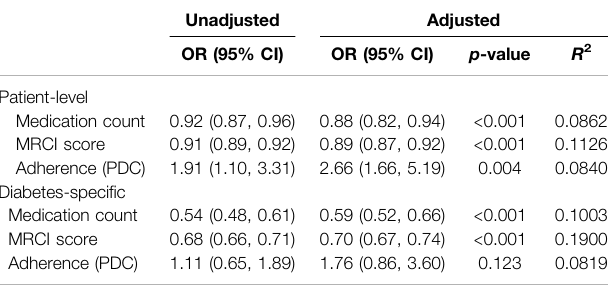
TABLE 3 | Association between medication parameters and HbA1c level ( ≤ 7.0%) of study cohort from “ EnPHC-Eva: Facility ” Malaysia, 2018-2019.